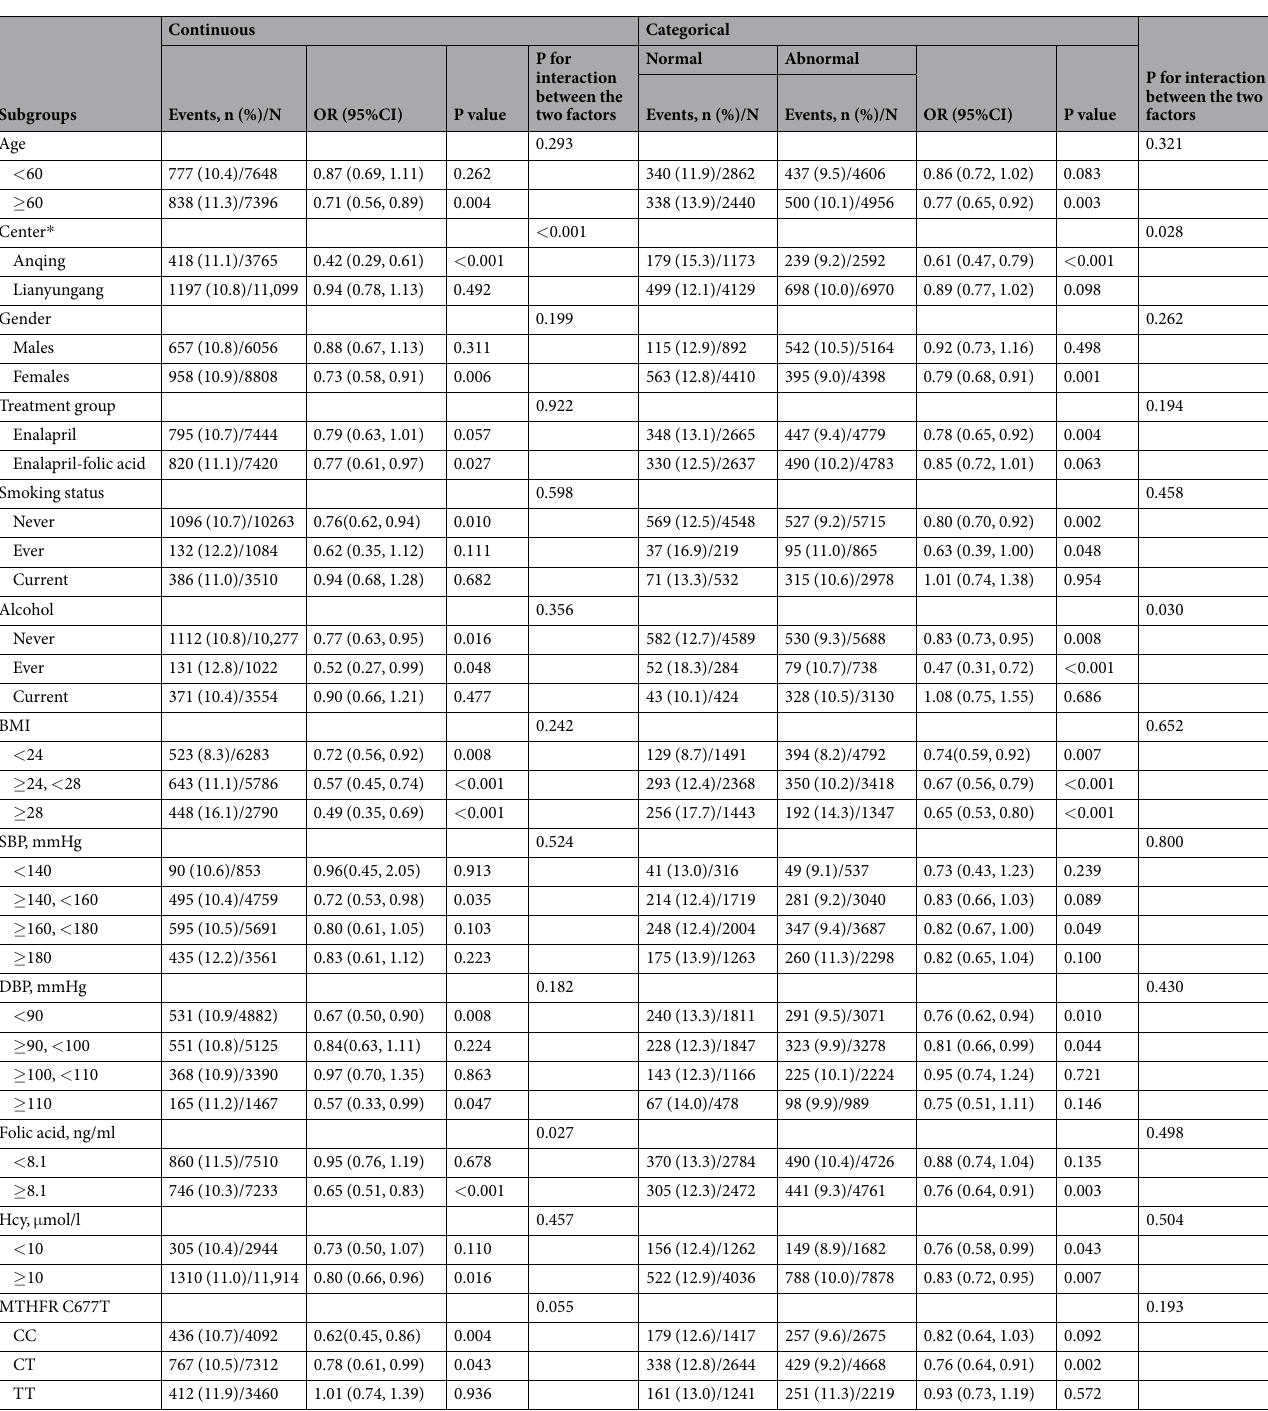
Table 5. Subgroup analysis of NOD risk associated with HDL according to important covariates by logistic regression. SBP = systolic blood pressure, DBP = diastolic blood pressure, TG = triglycerides, HDL = high-density lipoprotein, TC = total cholesterol, HCY = homocysteine, NOD = new-onset diabetes, MTHFR = methylenetetrahydrofolate reductase. * Clinical center represents two rural areas in Anhui and Jiangsu provinces in China. Adjusted for age, gender, clinical center, SBP, DBP, smoking and drinking status, baseline FPG, and BMI, if not stratified. Only TG levels were analyzed because of colinearity with TC and